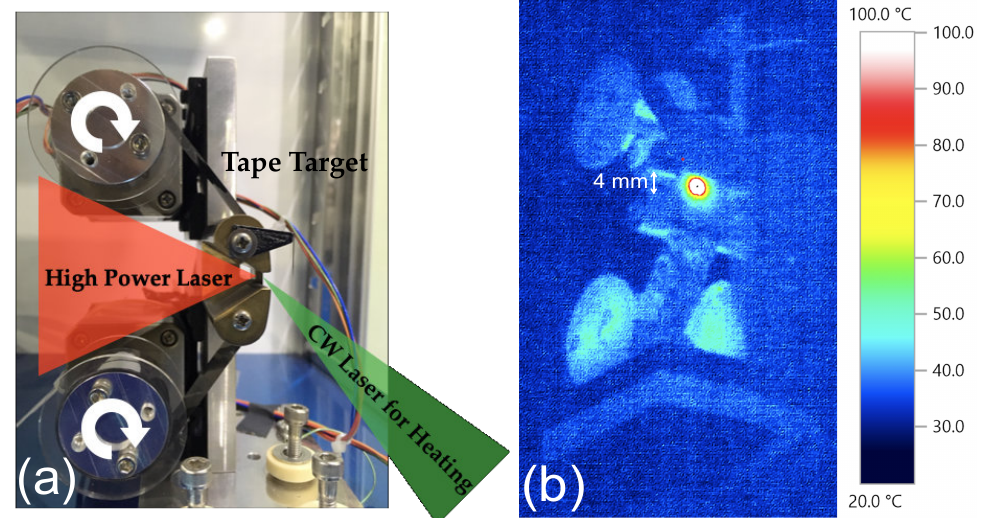
Figure 1. ( a ) The side view of the tape target overlaid with the orientations of the CW heating laser and the high-power laser for ion acceleration. ( b ) Temperature distribution of the CW laser-heated tape target, measured by IR thermography. The white region indicates a temperature exceeding 100 ◦ C.